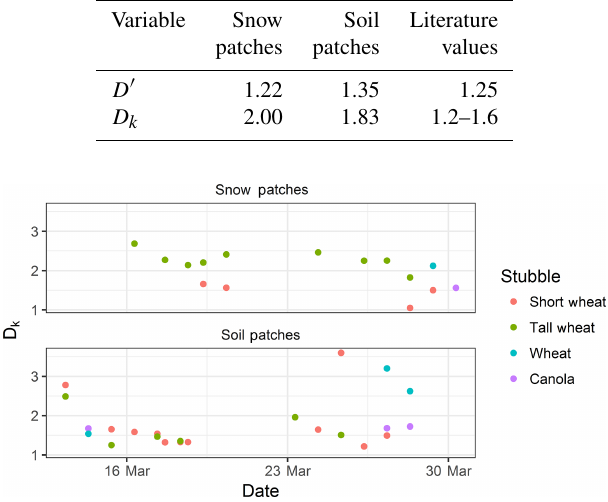
Figure 6. Time series of fitted D k parameter with respect to snow and soil patches for various land covers over the course of